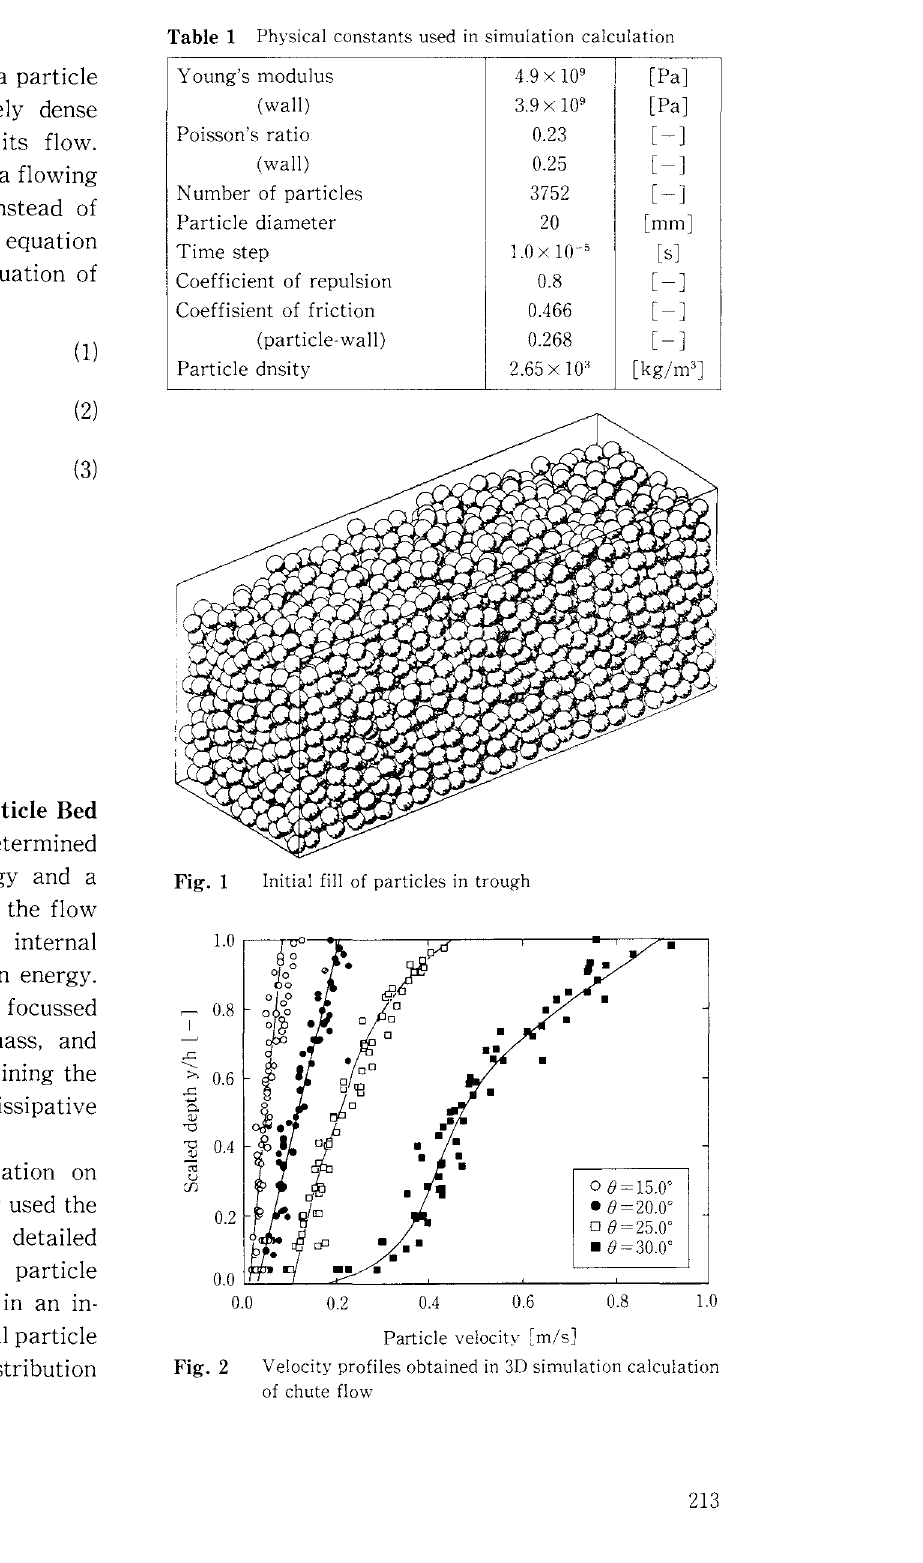
Velocity profiles obtained in 3D simulation calculation of chute